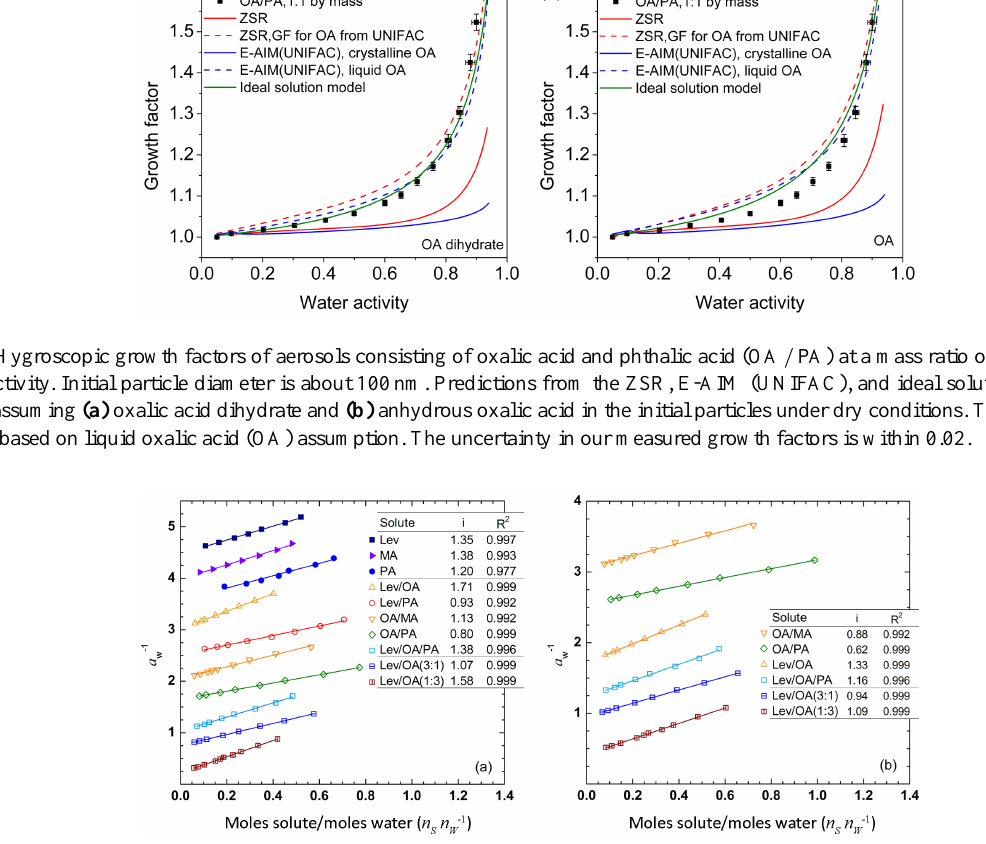
Figure 10. The inverse of the water activity ( a − 1 w ) as a function of the ratio of mole number of total solute to mole number of water ( n s /n w ) for all organic droplets. The slope of the fit line is equal to the van ’t Hoff factor ( i ). The R 2 values for the fit are also listed. Each data set was offset by a − 1 w = 0 . 3 from the previous data set for clarity. Calculations for aerosols containing oxalic acid are based on assumption of (a) oxalic acid dihydrate and (b) anhydrous oxalic acid. All the mixtures have equal mass composition except specially